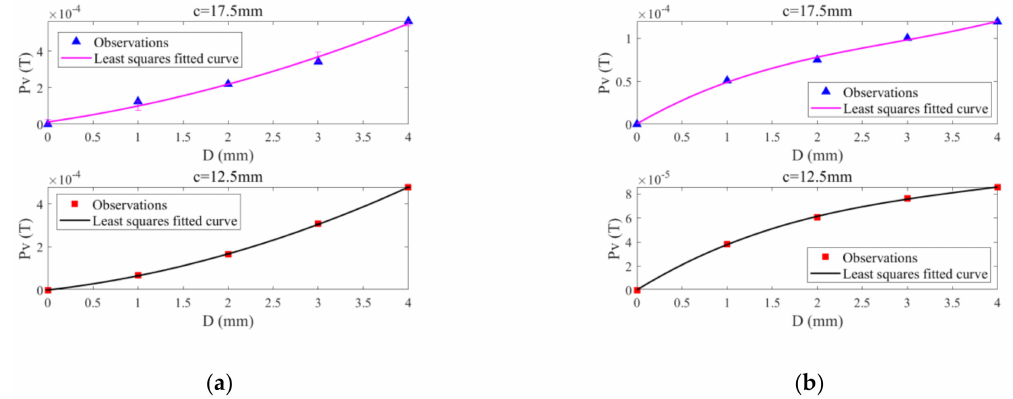
Figure 12. Pv against the ILC depth for: ( a ) ILC Scenario #1; ( b ) ILC Scenario